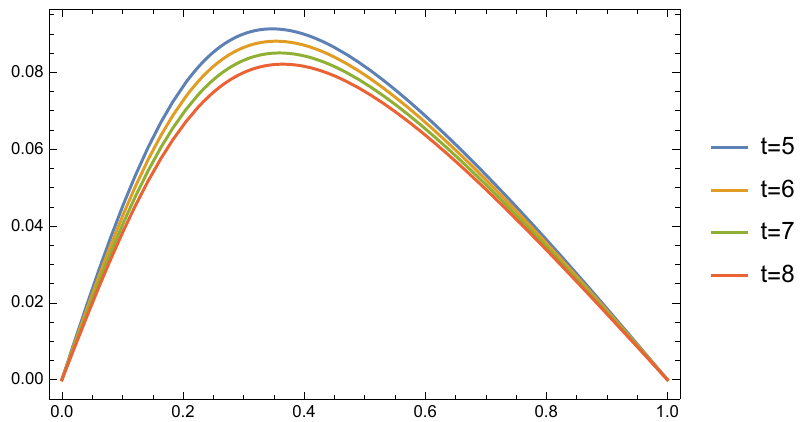
Figure 6. The approximate solutions of Example 3 at different times.